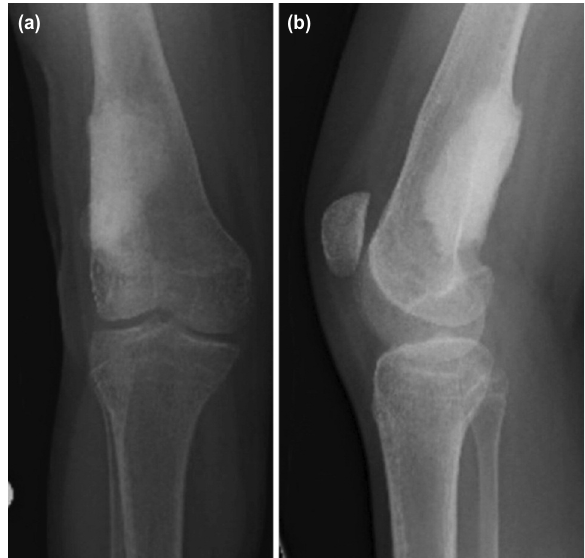
(a) Anteroposterior and (b) lateral radiographs of the Fig. 4: right knee at the 3rd year follow-up after plate removal, curettage and cement application. Radiographs show no evidence of